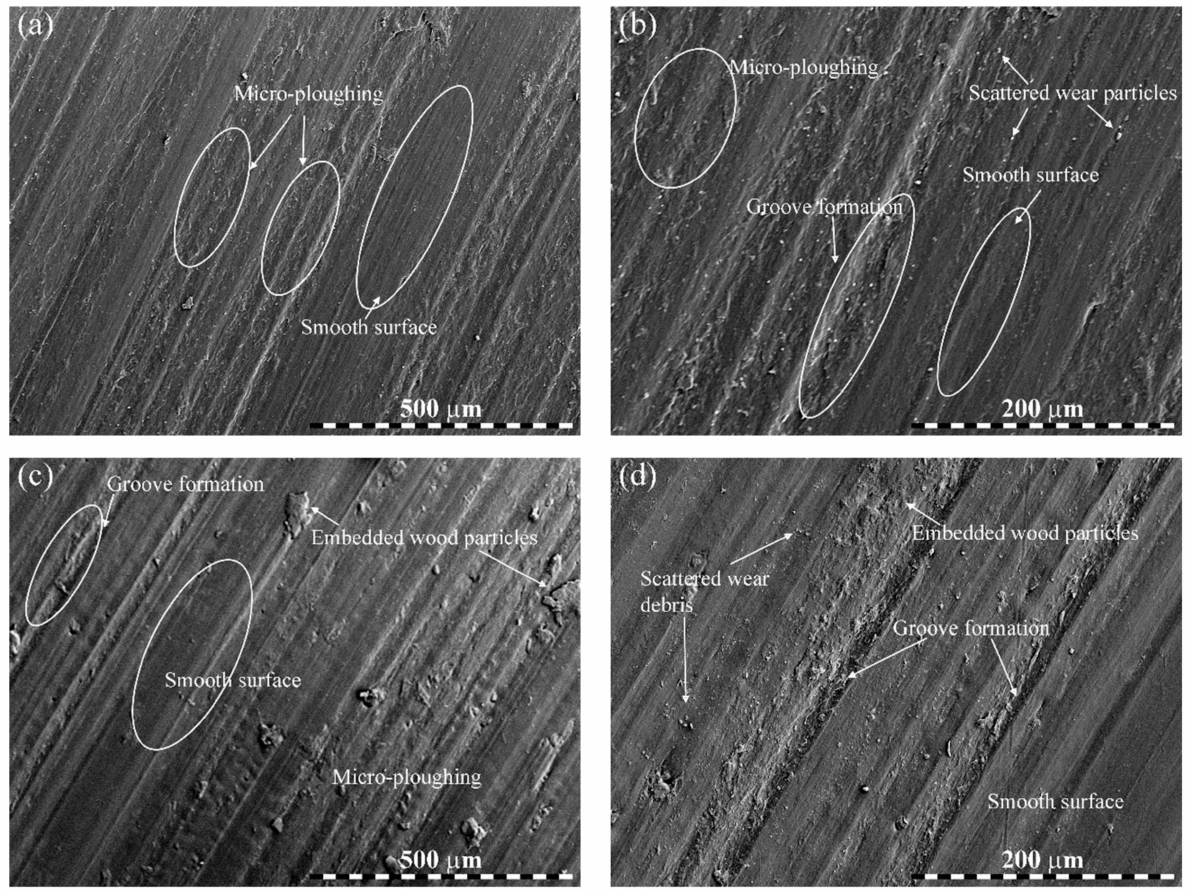
Figure 8. Worn micrographs of biocomposites: ( a , b ) bare PLA and ( c , d ) 2.5 wt.% wood waste-filled biocomposites at lower and higher